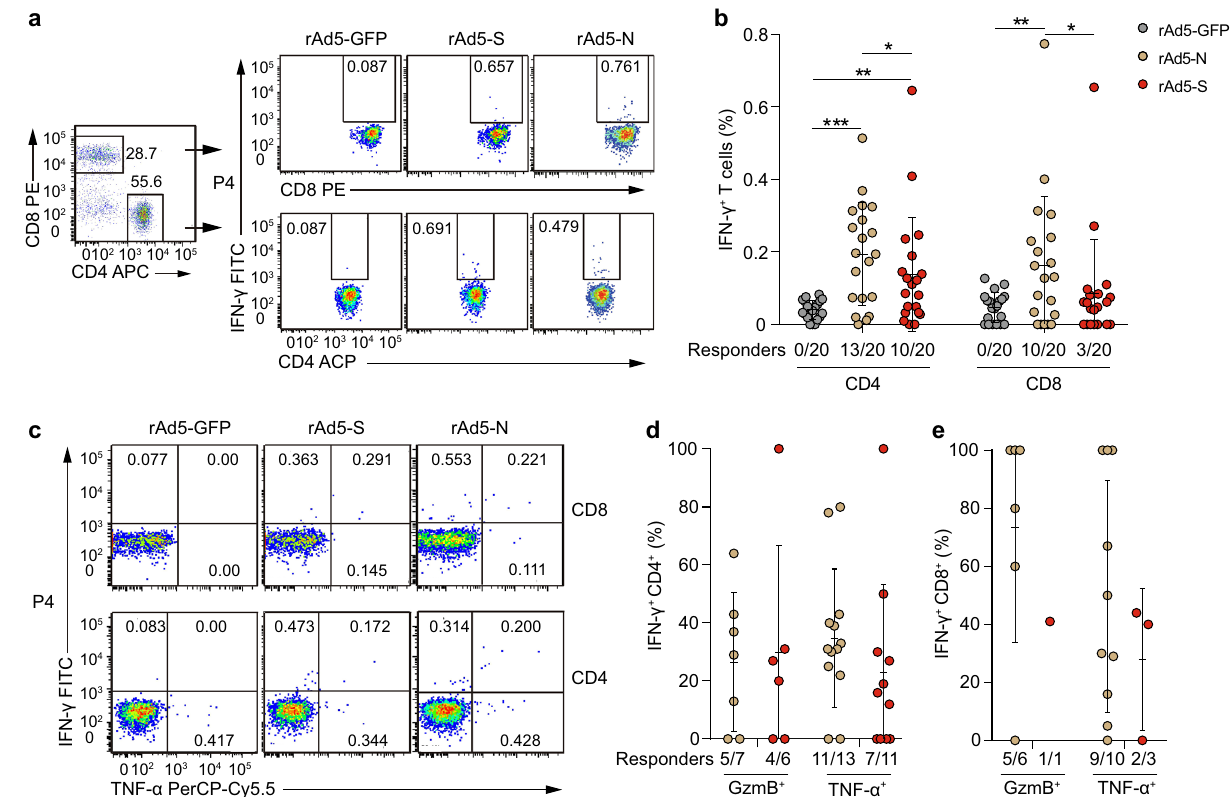
Fig. 3 SARS-CoV-2-speci fi c T cell responses in recovered COVID-19 patients 3 – 4 months after infection. a Fluorescence-activated cell sorting (FACS) plot example for analysing IFN- γ expression in CD4 and CD8 T cells is shown for patient No. 4 (Pt4). b Percentage of CD4 + and CD8 + T cells producing IFN- γ in response to a recombinant replication-de fi cient adenovirus type 5 that encodes green fl uorescent protein (rAd5-GFP), SARS-CoV-2 spike (rAd5- S), or SARS-CoV-2 nucleocapsid protein (rAd5-N) in PBMCs from recovered patients. c FACS plot examples of IFN- γ and granzyme B (GzmB) or TNF-a co-expression. d – e Functional pro fi le of IFN- γ + CD4 + ( d ) and CD8 + ( e ) T cells producing GzmB, or TNF-a in response to rAd5-S and rAd5-N. Data are expressed as mean ± SD for b , d and e . * p < 0.05, ** p < 0.01, and *** p < 0.001 by two-tailed paired t -test for b ( p = 0.0001, p = 0.0085, and p = 0.03 for CD4, and p = 0.009 and p = 0.174 for CD8). The two-tailed Mann – Whitney U -test was used for d and e . Gating strategies are in Supplementary Fig. 5. Source data included as a Source Data